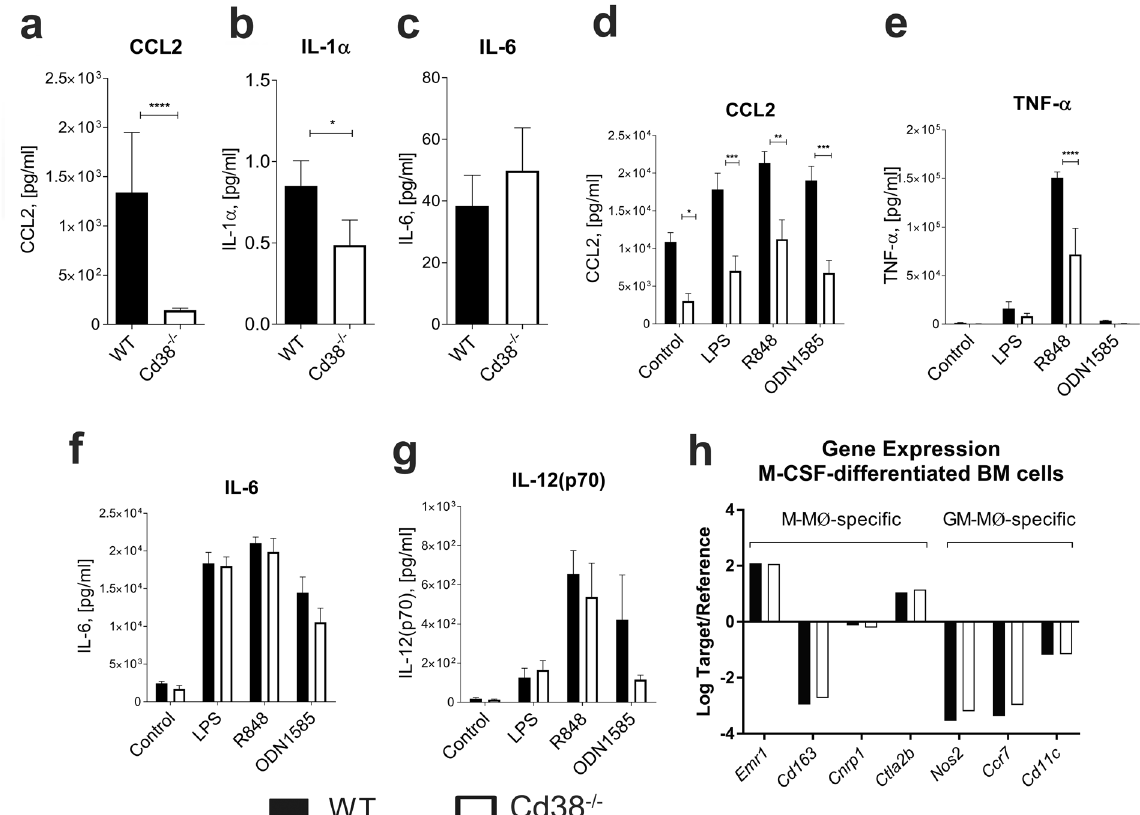
Figure 5. Defective pro-inflammatory phenotype of Cd38 − / − PECs but not BM-derived macrophages. ( a–c ) Decreased in vivo secretion of CCL2 and IL-1 α in pristane-treated Cd38 − / − mice. Concentration of CCL2 (a) , IL-1 α (b) and IL-6 (c ) proteins (pg/ml) in the peritoneal lavage fluid of 2-weeks pristane-treated WT and Cd38 − / − mice. Data are shown as the mean ± SE and represent cumulative data from 3 independent experiments (n = 15–22/group). * P < 0.05 **** P < 0.0001 by the Mann Whitney test. ( d–g ) Decreased in vitro secretion of CCL2 and TNF- α by pristane-elicited Cd38 − / − PECs in in response to the TLR7 agonist R848. Concentration of CCL2 (d) , TNF- α (e) , IL-6 (f) , and IL-12(p70) (g) proteins (pg/ml) in the supernatants of 2-weeks pristane-elicited PECs from WT and Cd38 − / − mice (5 mice/group) stimulated in vitro for 24 hours at 37 °C and 5% CO 2 with LPS, R848 or ODN1585. Each condition was tested in triplicate wells. Data are shown as the mean ± SE. * P < 0.05 ** P < 0.01 *** P < 0.001 by 2-way ANOVA with Bonferroni’s multiple comparisons test. (h) Normal M-CSF-induced differentiation of Cd38 − / − BM cells into anti-inflammatory macrophages. BM cells were isolated from naïve WT and Cd38 − / − mice and differentiated in vitro into anti-inflammatory macrophages (M-MØ) by culturing them for 7 days in the presence of murine M-CSF as described in Methods. Gene expression of mouse M-MØ-specific gene markers Emr1 , Cd163 , Cnrp1 , and Ctla2b , and pro- inflammatory macrophage (GM-MØ)-specific gene markers Nos2 , Ccr7 , and Cd11c was measured by